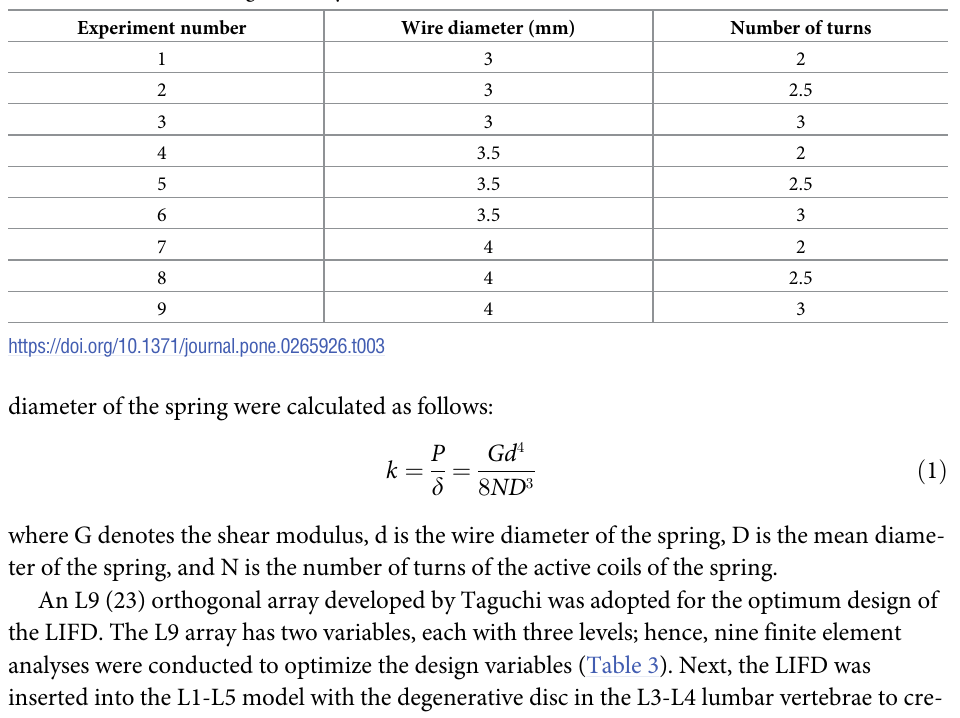
Table 3. Set of factors for Taguchi Array